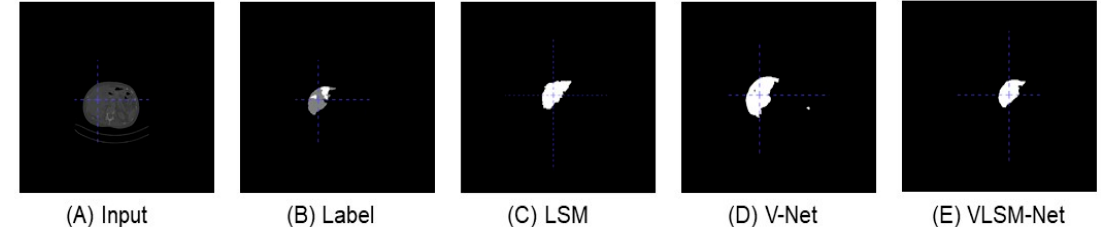
Figure 7. This is a top view display of the predicted images generated by different segmentation models in the LiTS dataset. ( A ) The original input image. ( B ) The label image. ( C ) The predicted image of the LSM. ( D ) The predicted image of the V-Net model. ( E ) The predicted image of the VLSM-Net.